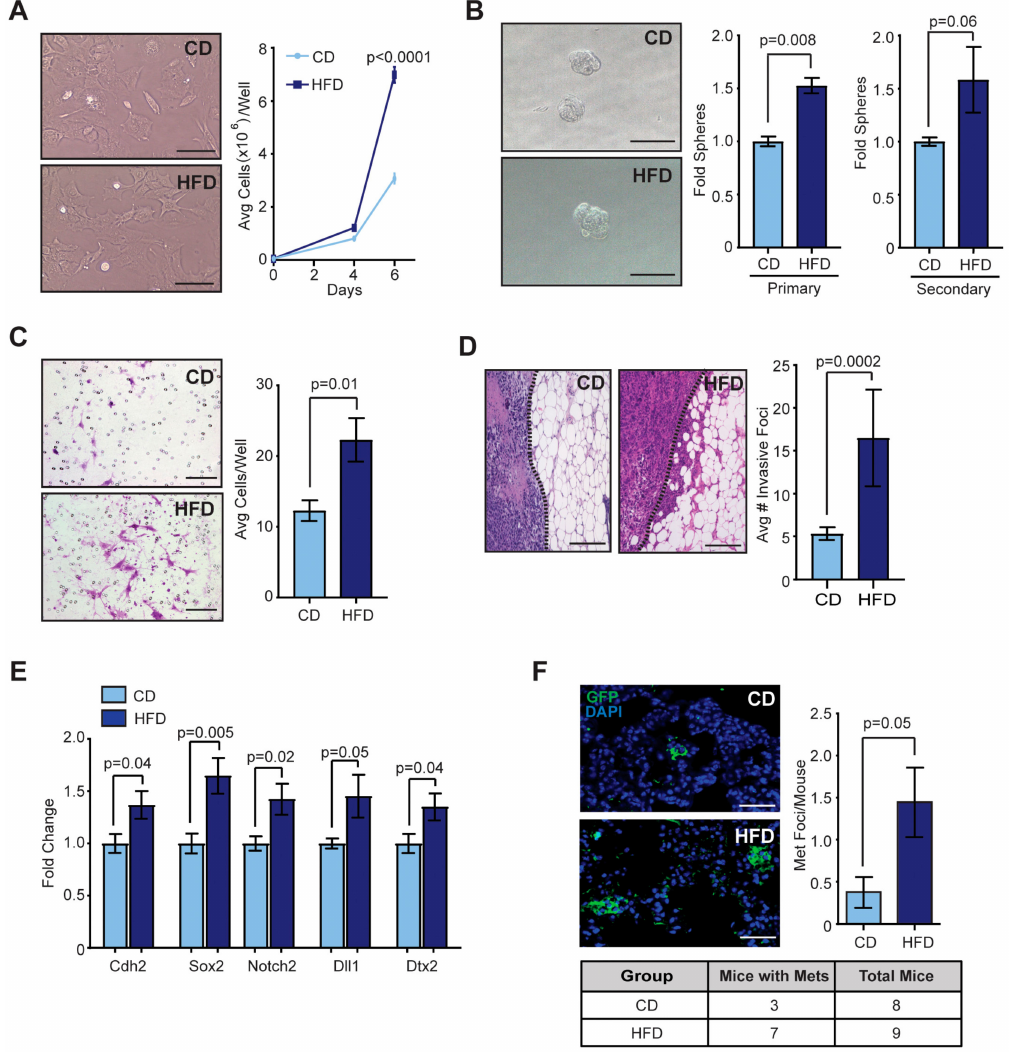
Figure 2. Mammary tumors from obese mice have increased properties of cancer stem-like cells. ( A ) Met-1 tumor cells isolated from lean and obese mice were plated in culture, and cell numbers were quantified after 4 and 6 days in culture ( n = 3 / group; two-way ANOVA with Tukey’s multiple comparisons test). ( B ) Isolated Met-1 tumor cells were plated in limiting dilution on non-adherent plates to form tumorspheres ( n = 6 / group; t -test). Tumorspheres were dissociated and re-plated to form secondary tumorspheres ( n = 6 / group; t -test). ( C ) Isolated Met-1 tumor cells were plated on collagen-coated migration chambers ( n = 3 / group; t-test). ( D ) Quantification of Met-1 tumor cell invasive foci into surrounding adipose tissue ( n = 6 / group; t -test). ( E ) Expression of markers of cancer stem-like cells (CSC)-like cells from isolated Met-1 tumor cells ( n = 6 / group; t -test). Expression di ff erences were normalized to ribosomal protein lateral stalk subunit P0 ( Rplp0 ) and represented as a fold change from controls. ( F ) Green fluorescent protein (GFP)-expressing Met-1 tumor cells were detected using immunofluorescence within the lungs ( n = 8–9 / group; t -test). Bars represent mean ± s.e.m. Magnification bars = 50 µ